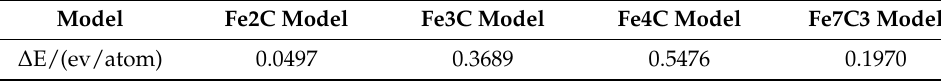
Figure 4. Strain and stress of all ferrite – carbide models. Table 3. MD-calculated Δ energy of various ferrite – cementite models.